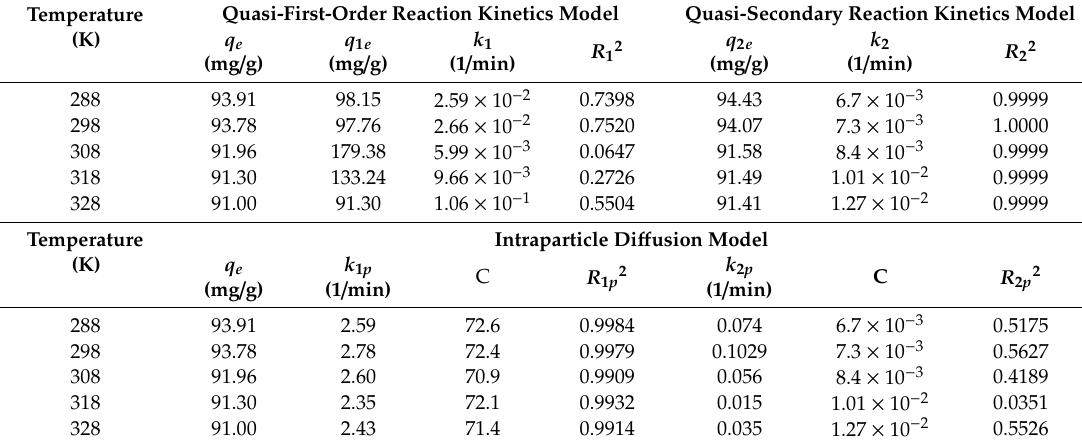
Table 2. E ff ect of Temperature on the Adsorption Kinetics Model. The Adsorption Test was Conducted with 200 mg / L Acid Orange II and 2 g / L Modified Sepiolite under an Oscillation Rate of 180 r / min and an Initial pH Value of